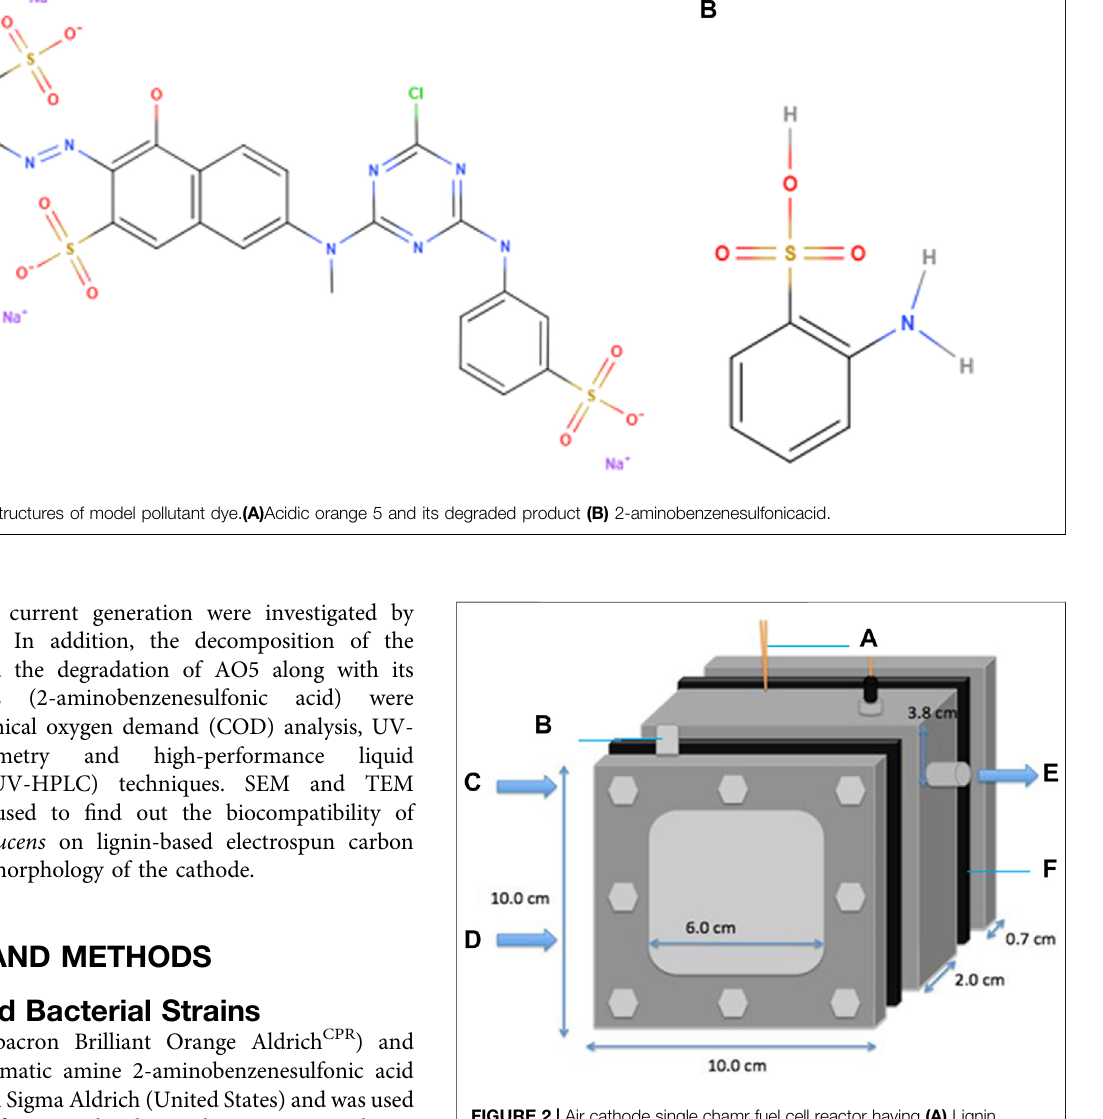
Frontiers in Energy Research |